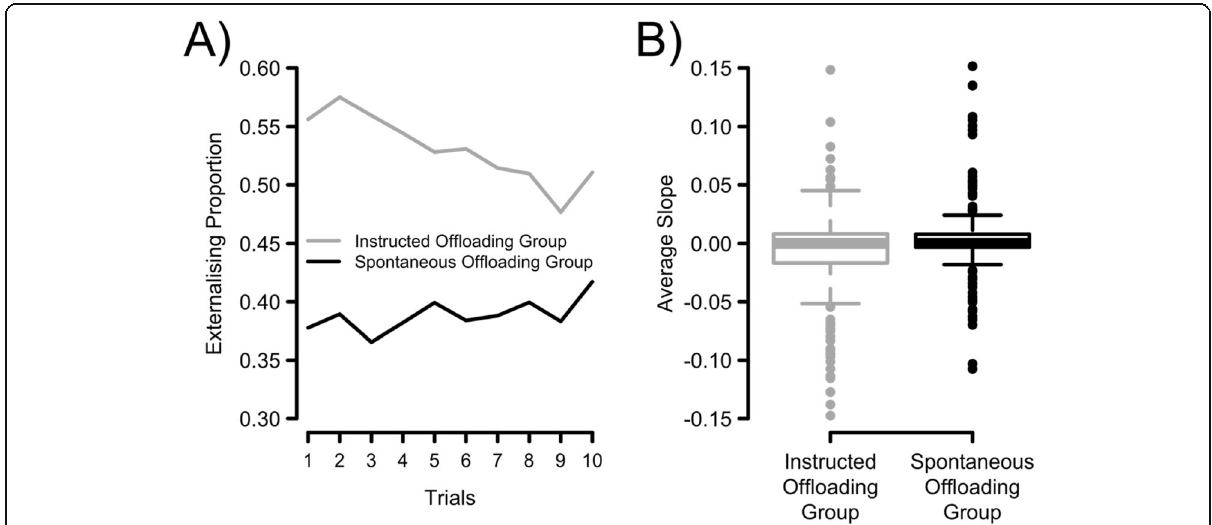
Fig. 4 a Externalising proportion (proportion of non-target trials moved minus proportion of target trials moved) across trials. b Group-wise distributions of individual slopes from a regression model in which trial predicts the externalising proportion. The boxplots reflect the interquartile range (IQR) together with the median. The whiskers span from the first quartile minus 1.5 times the IQR to the third quartile plus 1.5 times the IQR. Data points outside this inner fence are defined as outliers and are shown as individual data